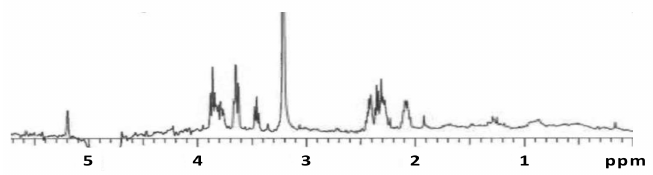
Figure 3. 1 H NMR spectrum of EPS isolated from D. alkanexedens .